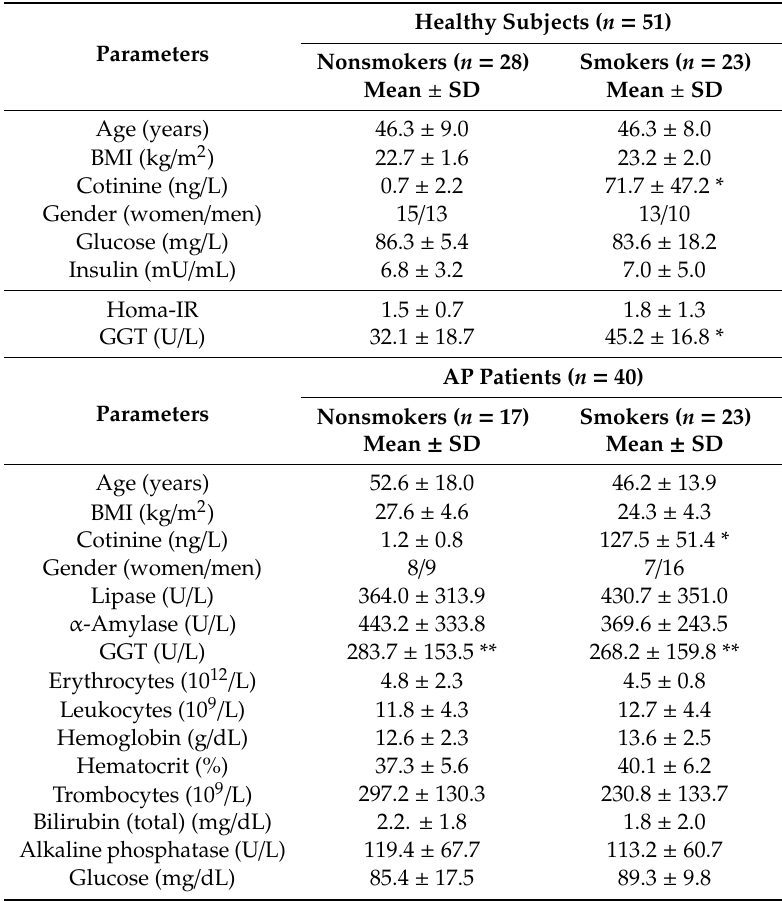
Table 2. The clinical characteristic of the study